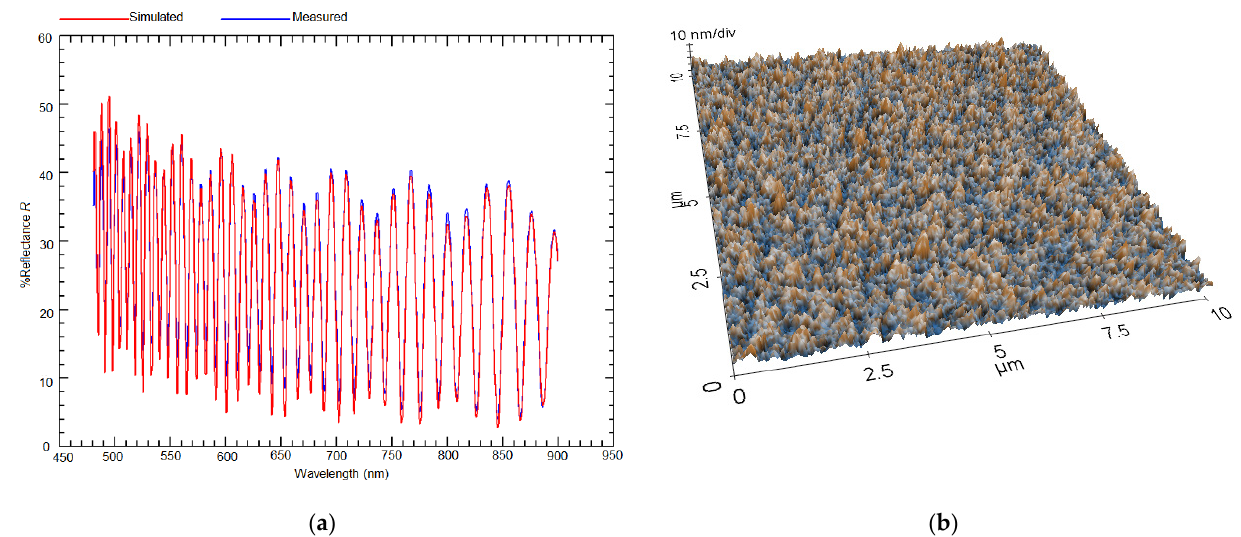
Figure 6. ( a ) Measured and simulated reflectance R of a thick SiON film as a function of wavelength λ; ( b ) topography of 10 × 10 µm 2 image of a thick SiON film.